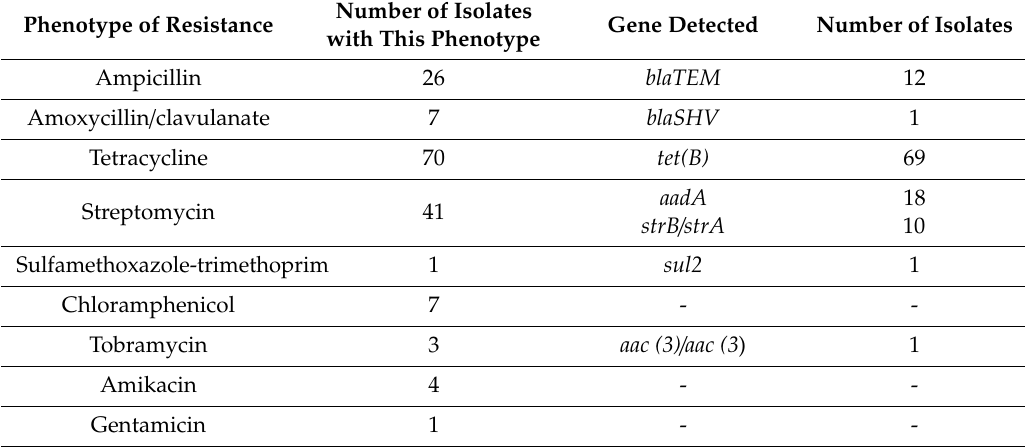
Table 5. Resistance genes detected among antibiotic resistant E. coli isolates of pastured goats origin. Number of Isolates Gene Detected Number of Isolates Phenotype of Resistance with This Phenotype Ampicillin 26 blaTEM Amoxycillin / clavulanate 7